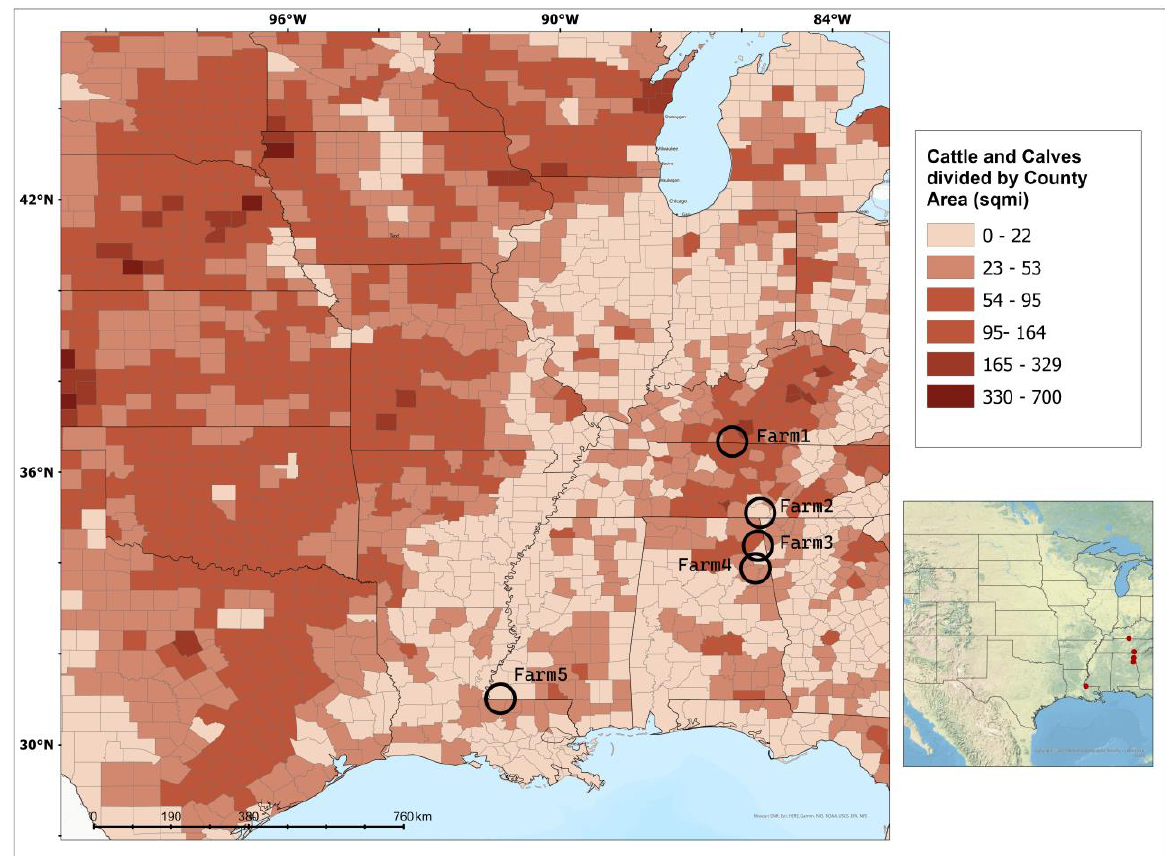
Figure 1. Study area showing the five pairs of adaptive and conventional grazing farms. Study sites are located in a latitudinal gradient from Adolphus, Kentucky, through Woodville, Mississippi. The map was elaborated in ArcGIS Pro using existing data sources USDA — NASS 2017, Census data.